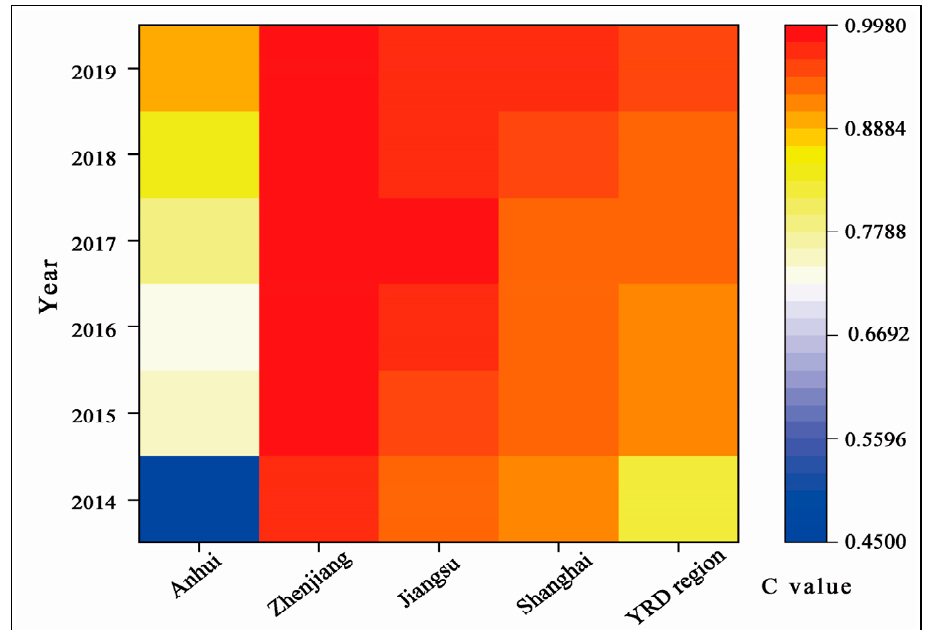
Figure 5. Evolution trends of coupling degree of innovation in the EROB composite system in the YRD region.